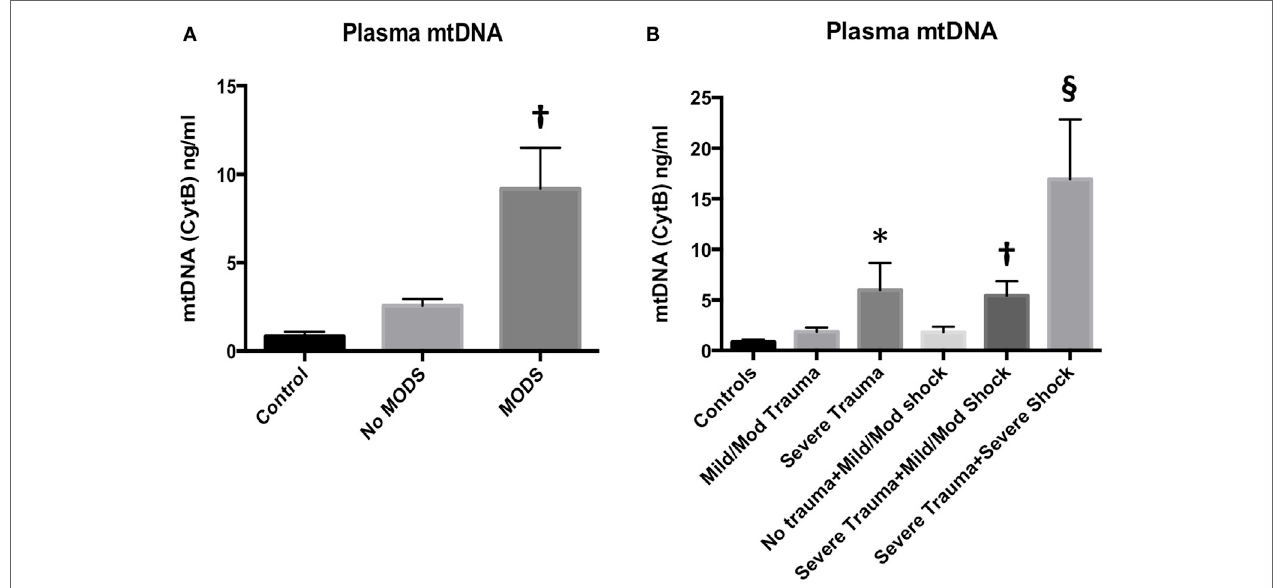
FigUre 1 | (a) (left) Plasma mitochondrial DNA (mtDNA) concentration at 2 h from injury is associated with the development of multiple organ dysfunction syndrome (MODS) in injured trauma patients. Injured patients who developed MODS ( n = 27) had higher concentrations of mtDNA (as measured by cytochrome B concentration) in their peripheral blood than injured patients who did not develop MODS ( n = 85). Control subjects had an Injury Severity Score (ISS) of 0–4 and normal base excess ( n = 16) mean (95% CI): 0.9 (0.4–1.3) ng/ml, no MODS: 2.6 (1.8–3.3) ng/ml, MODS 9.2 (4.6–13.7) ng/ml. Bar graphs indicate mean values with SEM. † denotes p < 0.01 when no MODS and MODS groups were compared with a t -test. DNA was extracted from cell-free plasma and mtDNA was measured using real-time polymerase chain reaction with cytochrome B as the target gene. (B) (right) Plasma mtDNA concentration in patients at admission with increasing tissue injury and shock from left to right. mtDNA levels demonstrated a dose-dependent relationship with ISS. Controls (ISS 0–4 and normal base excess, n = 16) mean ± SEM mtDNA 0.8471 ± 0.2525 ng/ml, mild/moderate trauma (ISS 5–24, normal BE, n = 34), 1.850 ± 0.4266, and severe trauma (ISS ≥ 25, normal BE,